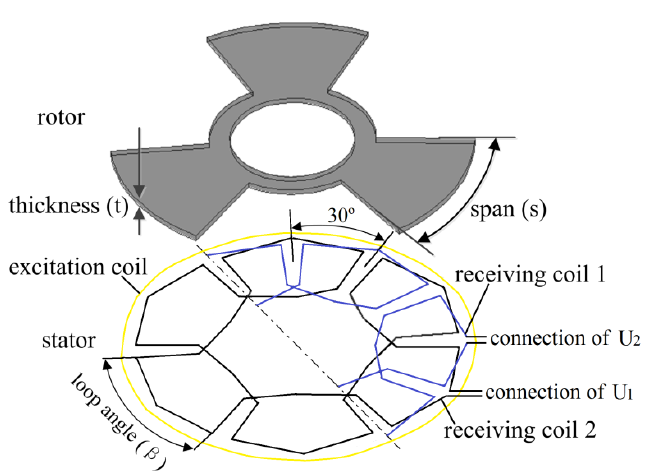
Figure 1. View of inductive angle